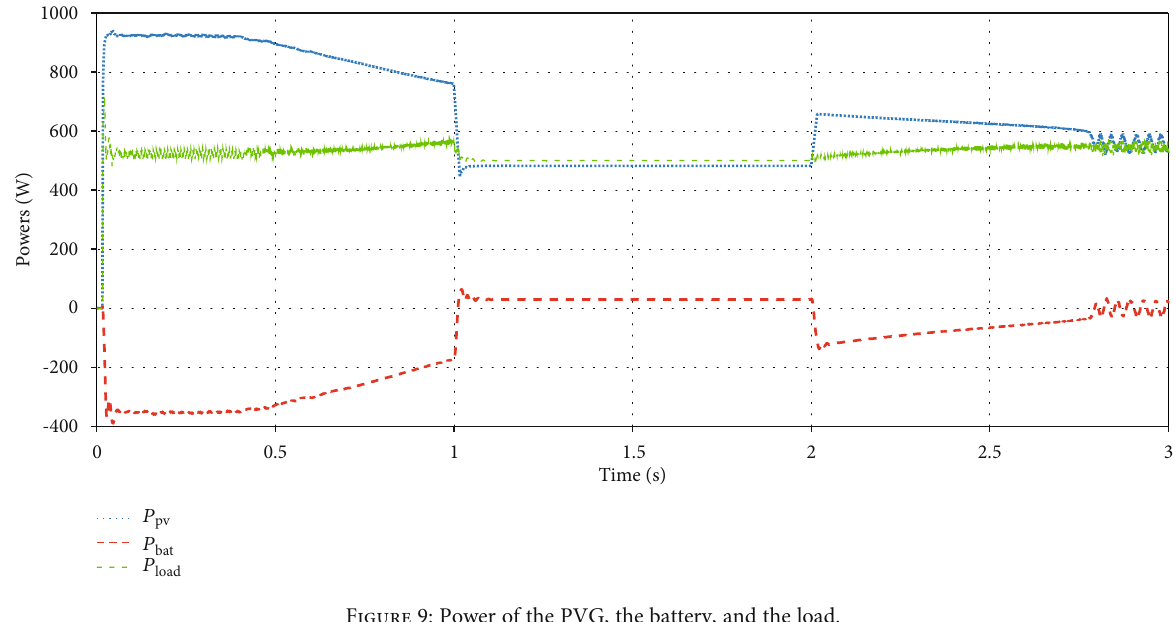
Figure 9: Power of the PVG, the battery, and the